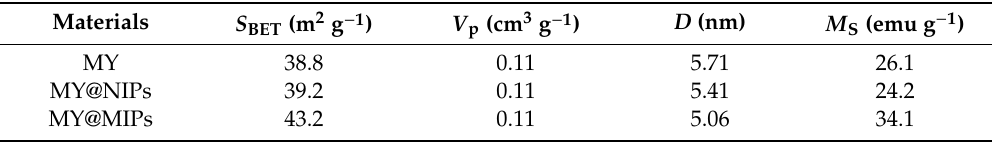
Table 1. Physical characterization of the produced materials.